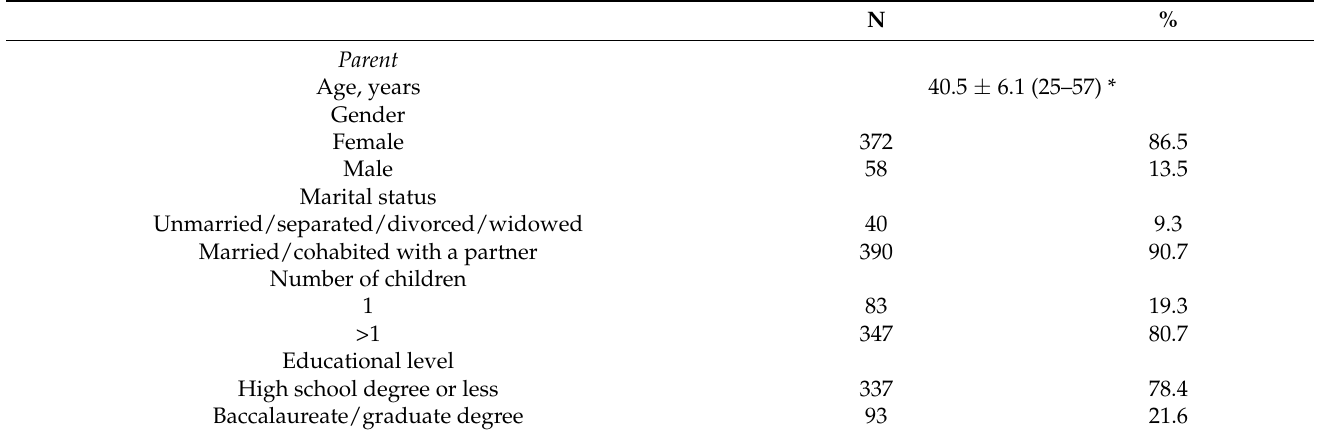
Table 1. Socio-demographic and key characteristics of the study